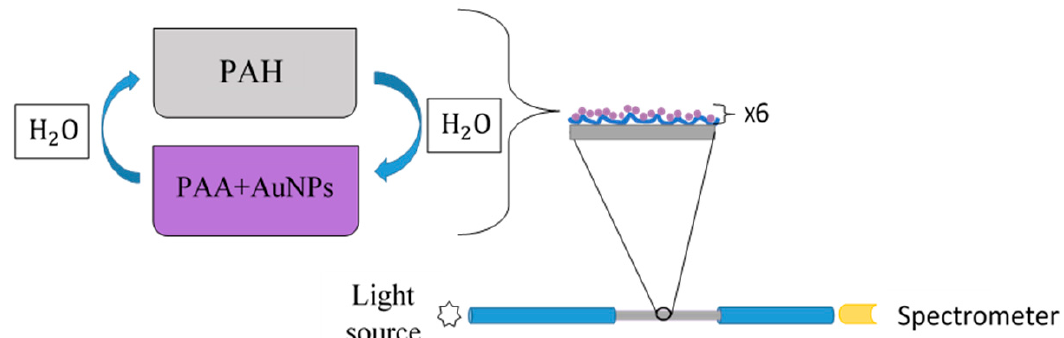
Figure 1. Layer-by-layer nano-assembly built-up of the sensitive coatings. Construction of fiber optic sensor with (PAH / PAA + AuNPs) 6 over a cladding-removed 200 µ m-core optical fiber.